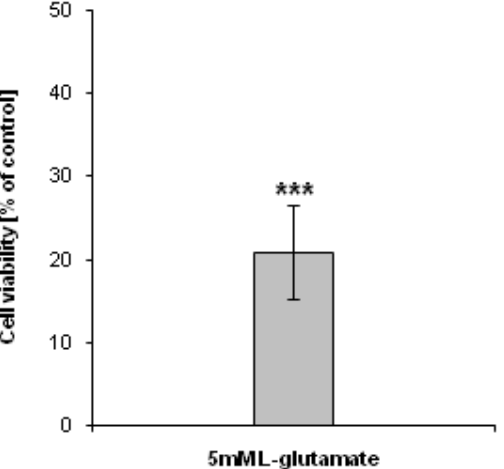
Figure 2. Antiproliferative effect of L -glutamate. HT22 cells were treated with 5 mM L -glutamate for 24 h. The cell viability was assessed using the 3-[4,5-dimethylthiazol- 2-yl]-2,5-diphenyltetrazolium bromide (MTT) assay. Data are presented as mean ± SD. *** p <0.001, statistically significant differences compared to control (untreated)